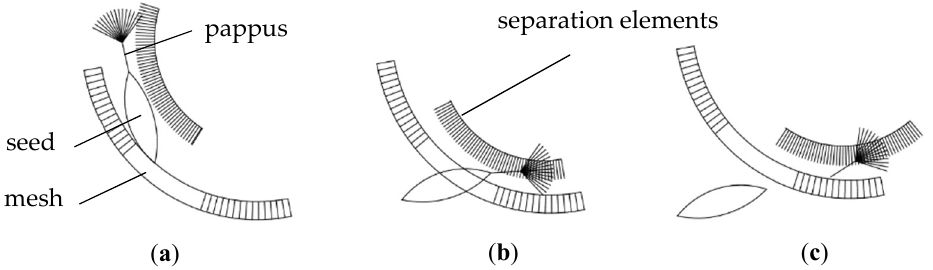
Figure 12. Schematic diagram of separation process of grain and crown hair. ( a ) Before separation. ( b ) During separation. ( c ) After separation.